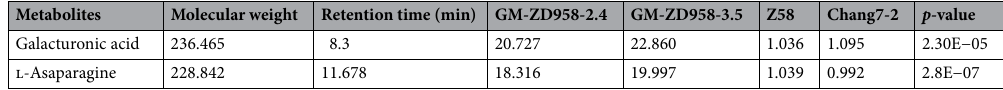
Table 3. Fold change for top 5% DAM in HIR gene cassette GM-ZD958 transgenic lines and its nonGM parents (Z58 and Chang7-2), relative to nonGM-ZD958 determined in growth chamber. P -value represent the significant levels performed by one-way ANOVA among different maize